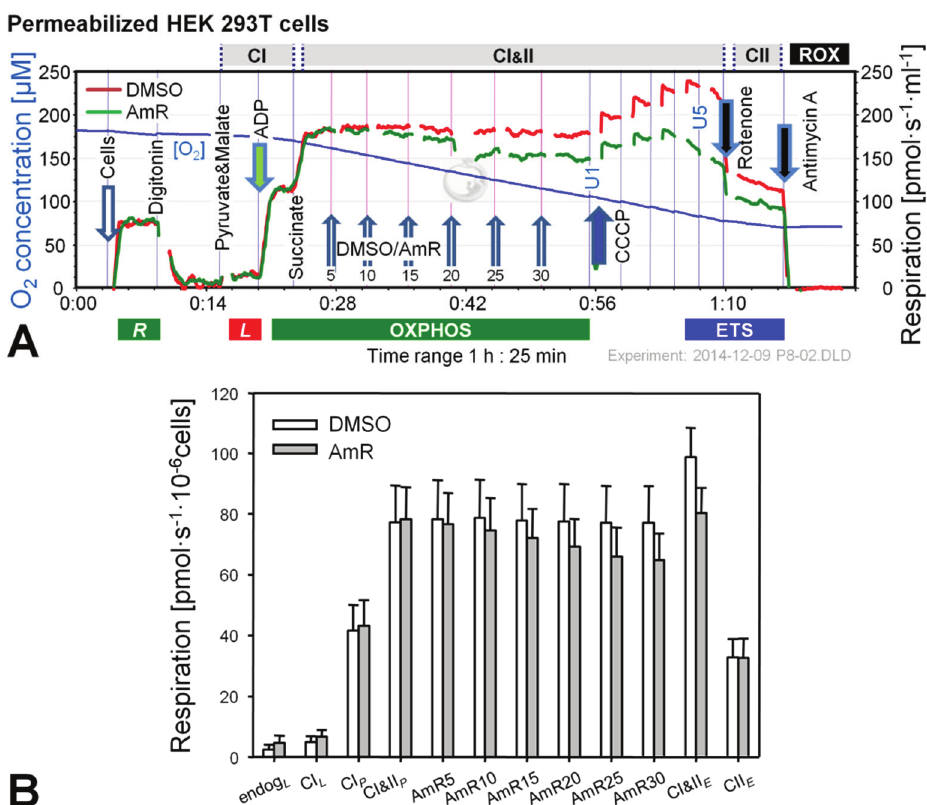
Figure 2. Effect of AmR on respiration of permeabilized HEK 293T cells. ( A ) Representative experiment with AmR (green plot) or carrier DMSO (red plot) titrated in the CI & II-linked OXPHOS state. Substrate states and coupling states are shown by horizontal bars. Numbers indicate final Amp concentrations [μM]; U1 and U5 indicate final uncoupler concentrations [μM] added in 1 μM steps; ( B ) Oxygen flow [pmol(cid:3)s (cid:2)1 ·10 (cid:2)6 cells], mean ± SE of N = 5 independent cultures, each measured in duplicate ( n =